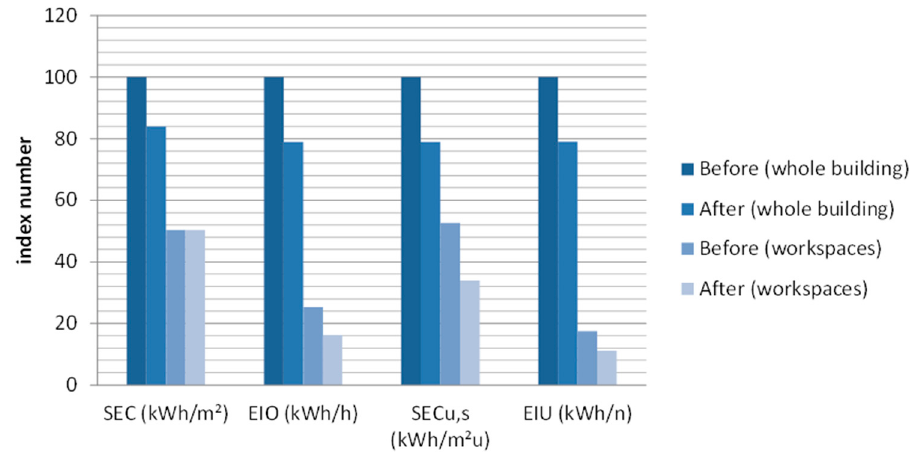
Figure 7. Indexed values (100 = whole building before the renovation) for energy efficiency indicators for the whole building and the workspaces.